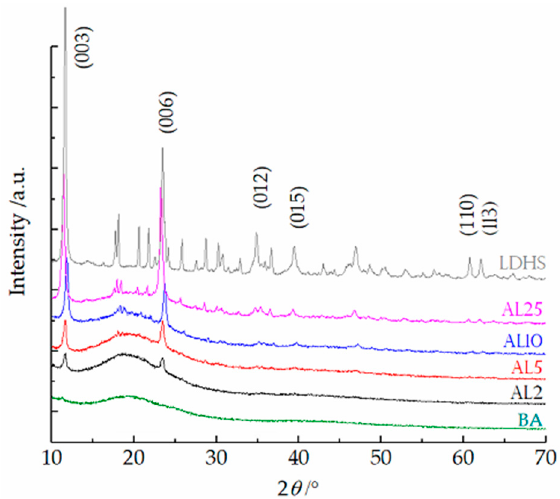
Figure 1. XRD patterns of base asphalt (BA), AL2 (asphalt/2 wt.% LDHs), AL5 (asphalt/5 wt.% LDHs), AL10 (asphalt/10 wt.% LDHs), AL25 (asphalt/25 wt.% LDHs), and LDHs.